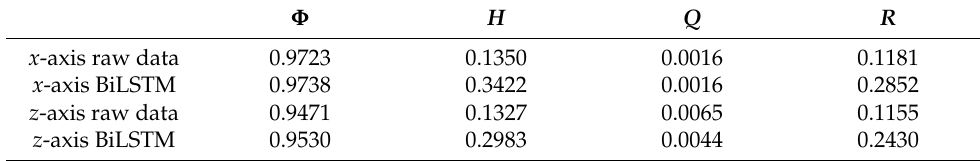
Figure 8. Log-likelihood value change of the iteration epoch. Table 9. The parameter estimation results. Φ